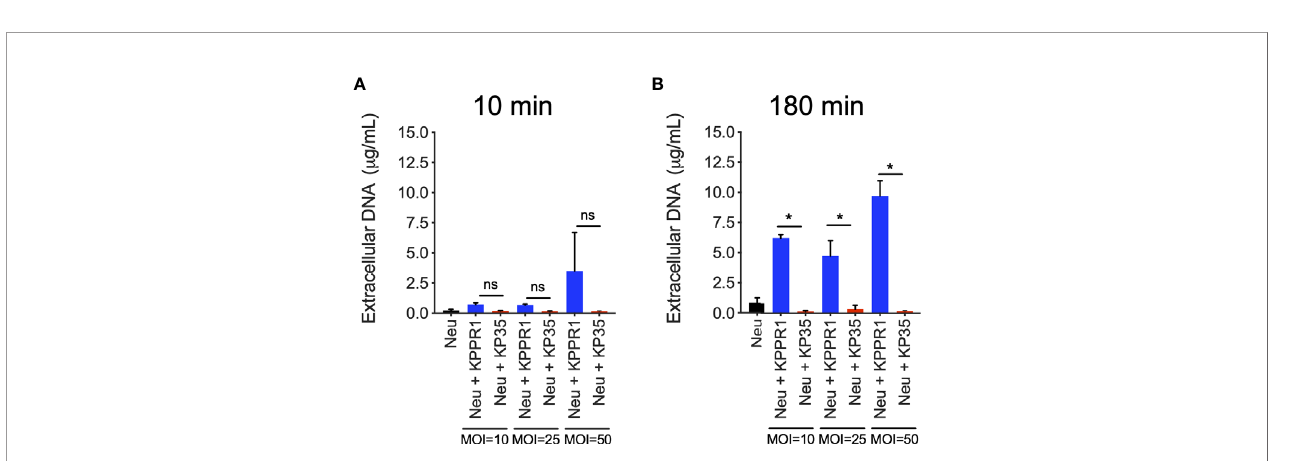
FIGURE 3 | KP35 does not induce release of neutrophil DNA to the extracellular space. DNA release to the supernatant by KPPR1 and KP35 (MOIs 10, 25 and 50) infected neutrophils was evaluated at (A) 10 min and (B) 180 min. *P < 0.05, for multiple comparisons, one-way ANOVA test followed by a Tukey ’ s test for multiple comparisons. ns, non signi fi